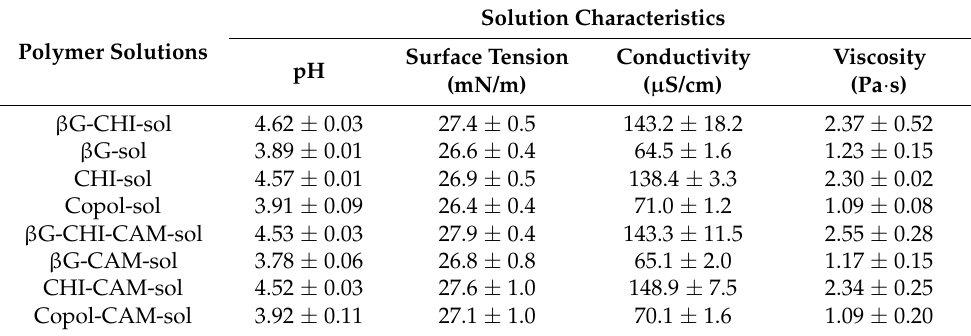
Table 2. Polymer solution characteristics. Results are presented as mean ± SD ( n = 3).